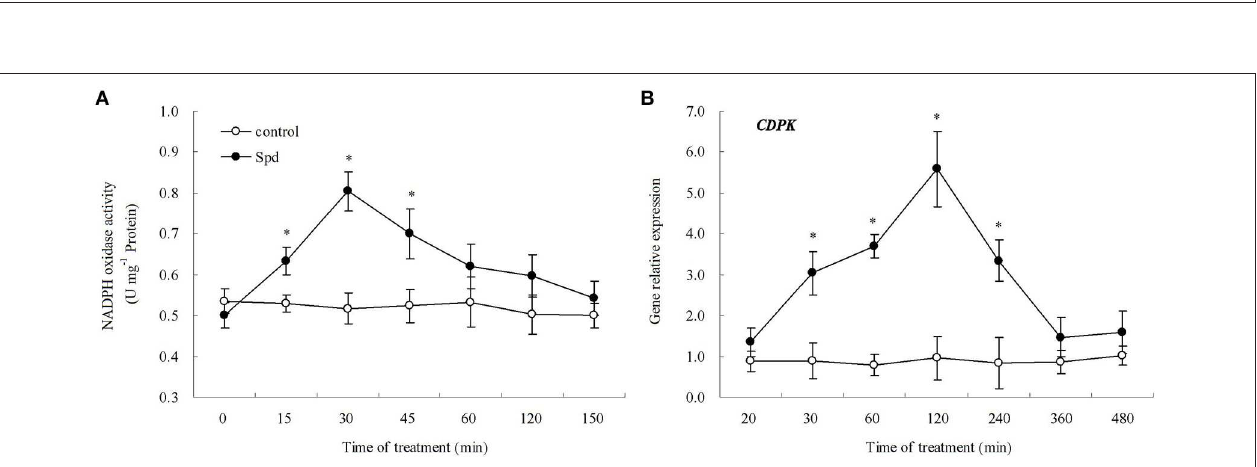
FIGURE 7 | Time course of spermidine (Spd)-induced NADPH oxidase activity (A), and CDPK gene relative expression (B) in leaves. The detached leaves were pre-treated with distilled water for 1h to eliminate wound stress and then exposed to distilled water (control) or 20 µ m Spd solution for 480min. Means of four independent samples are presented. Bars represent standard error. “ * ” indicate LSD values where significant differences were detected ( P < 0.05) between two treatments at a given time.